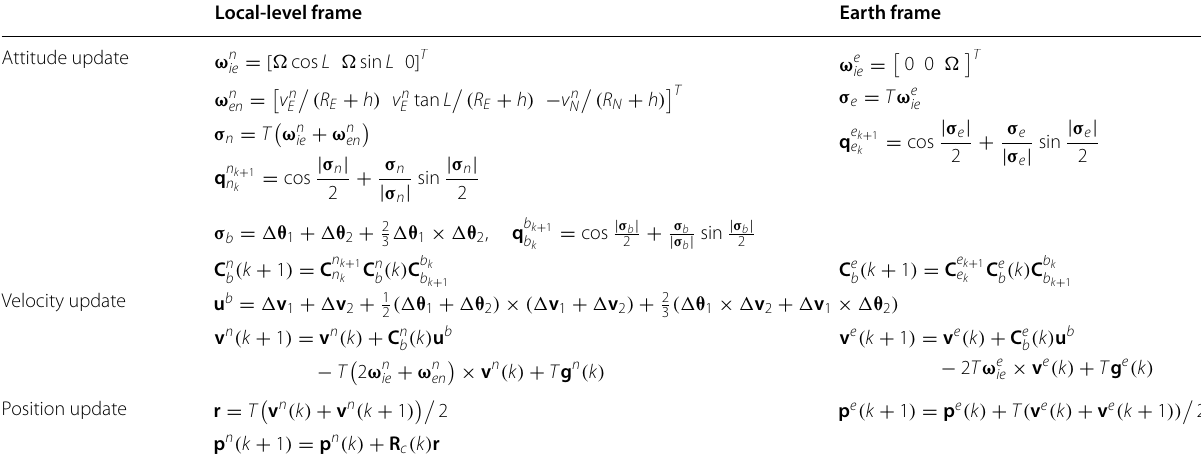
Table 1 Two-sample inertial navigation computation in local-level frame and Earth frame Local-level frame Earth frame